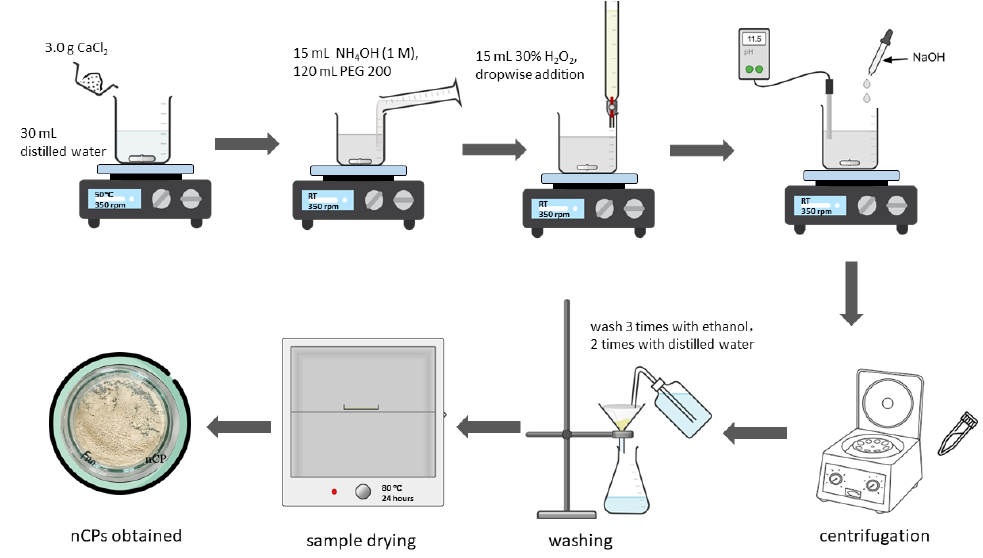
Figure 2. A schematic diagram of synthesis of nCPs.